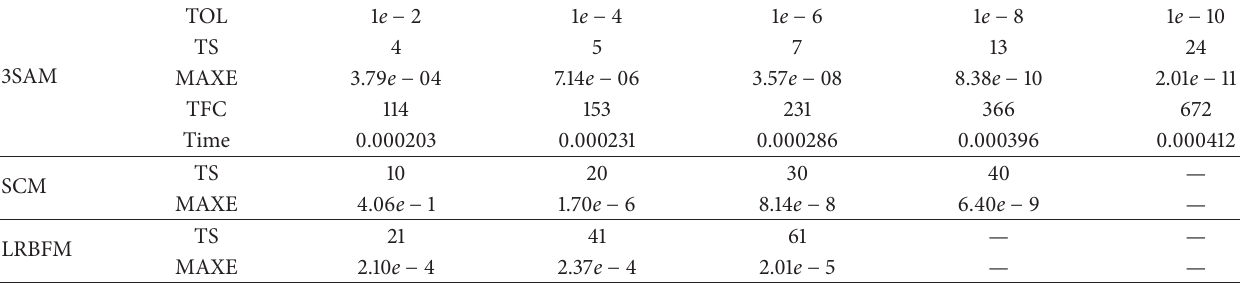
Table 3: Comparison of the numerical result for solving Problem